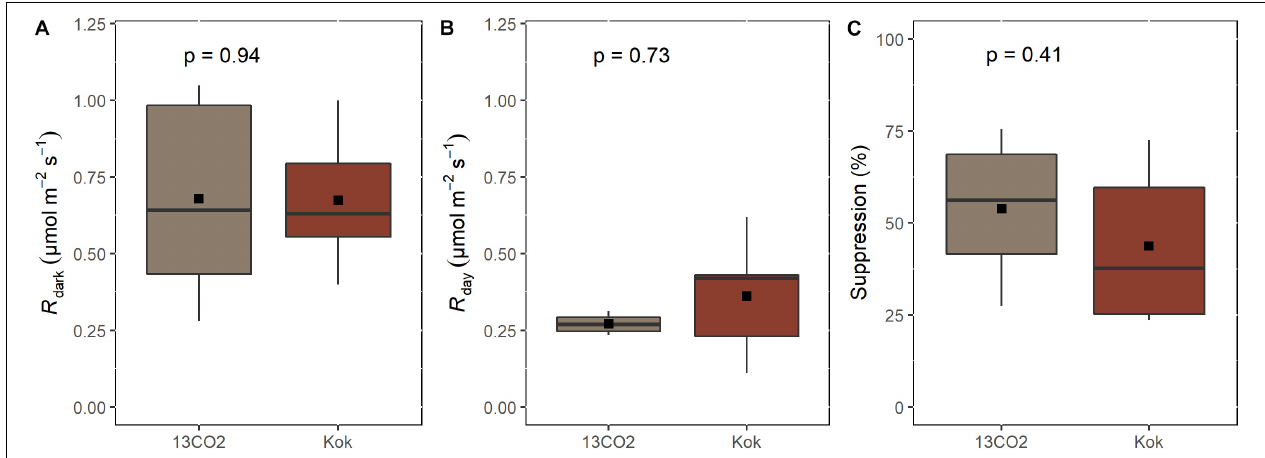
FIGURE 1 | Comparison between Kok and 13 CO 2 method for estimating leaf respiration rates in the dark (R dark ) (A) ; in the light (R day ) (B) , and the suppression of R dark (Suppression) (C) . The line inside the box indicates the median of the data, the colored bar represents the 50% variation of the data, the vertical lines represent the 90% of the variation, and the square point inside the colored box represents the mean. ( n = 4–6) The test used was Wilcoxon-test.